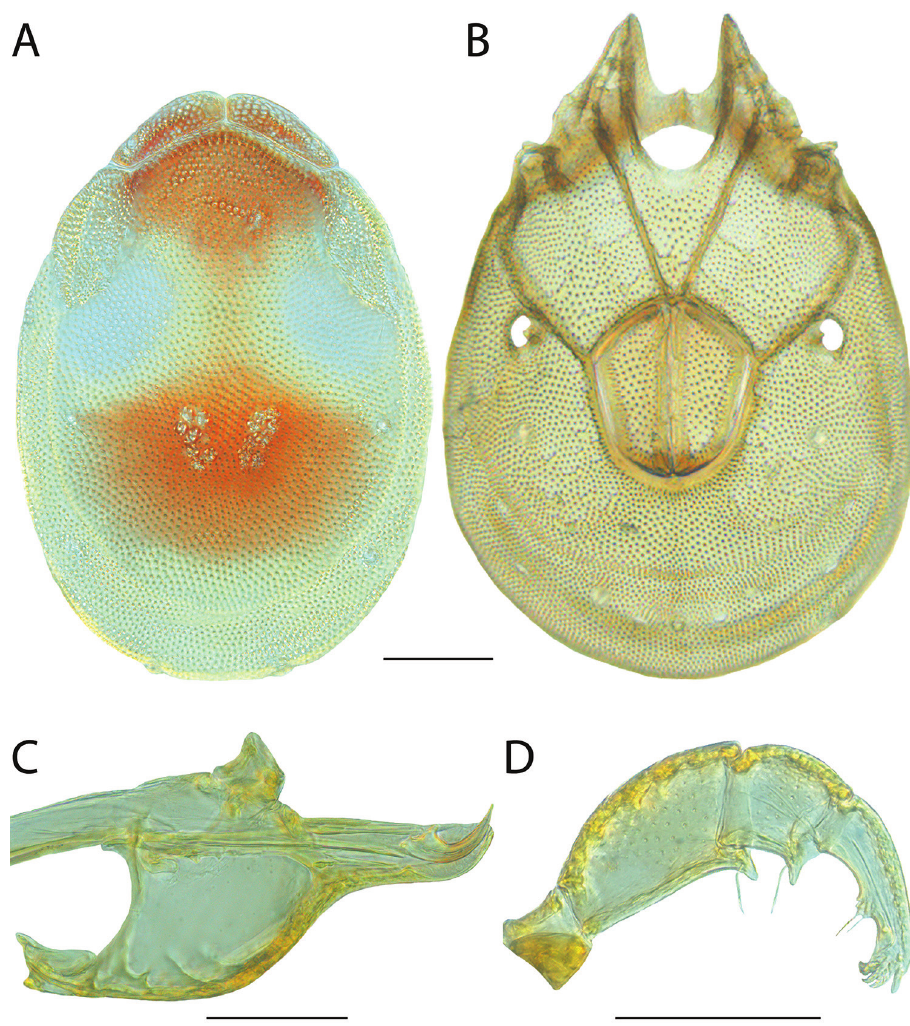
Figure 51. Torrenticola delicatexa female: A dorsal plates B venter (legs removed) C subcapitulum D pedi- palp (setae not accurately depicted). Scale = 100